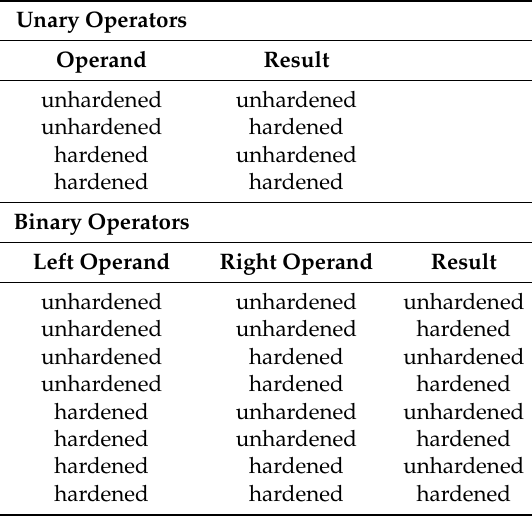
Table 3. Operator